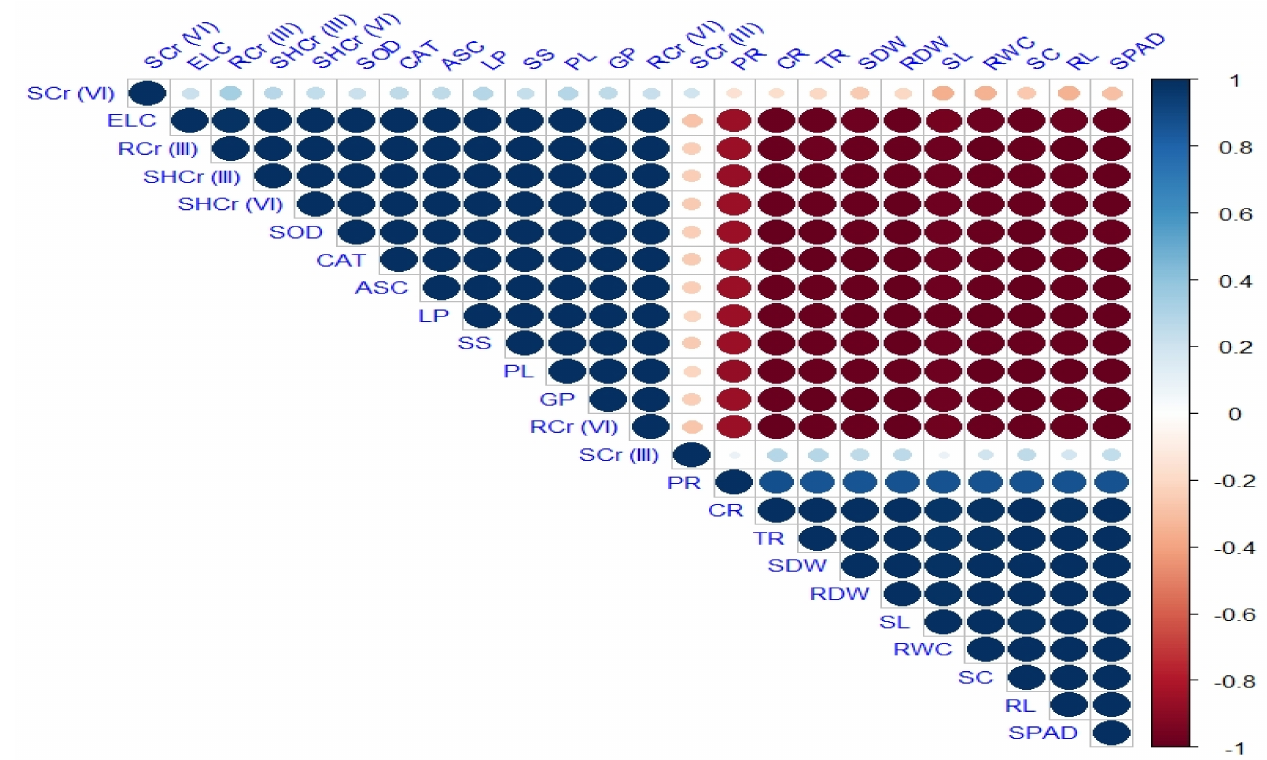
Figure 3. Correlation matrix representing correlation among different attributes of maize crop followed by different treatments, such as Kasur soils (0% biochar) (1) NK − 8441, (2) P − 1543, (3) NK − 8711, (4) FH − 985; (3% biochar) (5) NK − 8441, (6) P − 1543, (7) NK − 8711, (8) FH − 985; Sialkot soils (0% biochar) (9) NK − 8441, (10) P − 1543, (11) NK − 8711, (12) FH − 985; (3% biochar) (13) NK − 8441, (14) P − 1543, (15) NK − 8711, (16) FH − 985. Positive correlations are displayed in blue and negative correlations in red. The color legend on the right-hand side of the correlogram shows the correlation coefficients and the corresponding colors. The abbreviations are as follows: Shoot length: SL, Root length: RL, Shoot dry weight: SDW, Root dry weight: RDW, Chlorophyll contents: SPAD, Photosynthetic rate: PR, Transpiration rate: TR, Stomatal conductance: SC, Lipid peroxidation: LP, Proline contents: PL, Total carotenoids: CR, Soil Cr lll: SCrlll, Shoot Cr III: SHCrIII, Root Cr III: RCrIII, Soil Cr VI: SCrVl, Shoot Cr VI: SHCrVI, Root Cr VI: RCrVI, Relative water contents: RWC, Electrolyte leakage: ELC, Catalase: CAT, Ascorbate peroxidase: ASC, Glutathione peroxidase: GP, Soluble sugars: SS, and